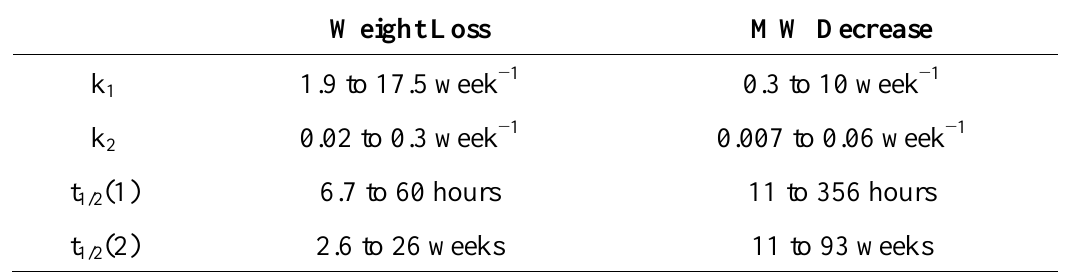
Table 5. Comparison between rate constants of weight loss and molecular weight change